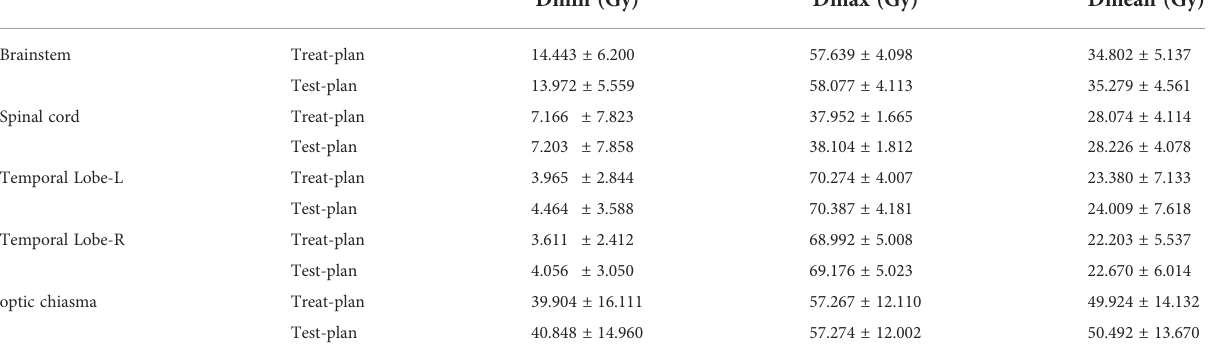
TABLE 4 Normal organs evaluation in T4